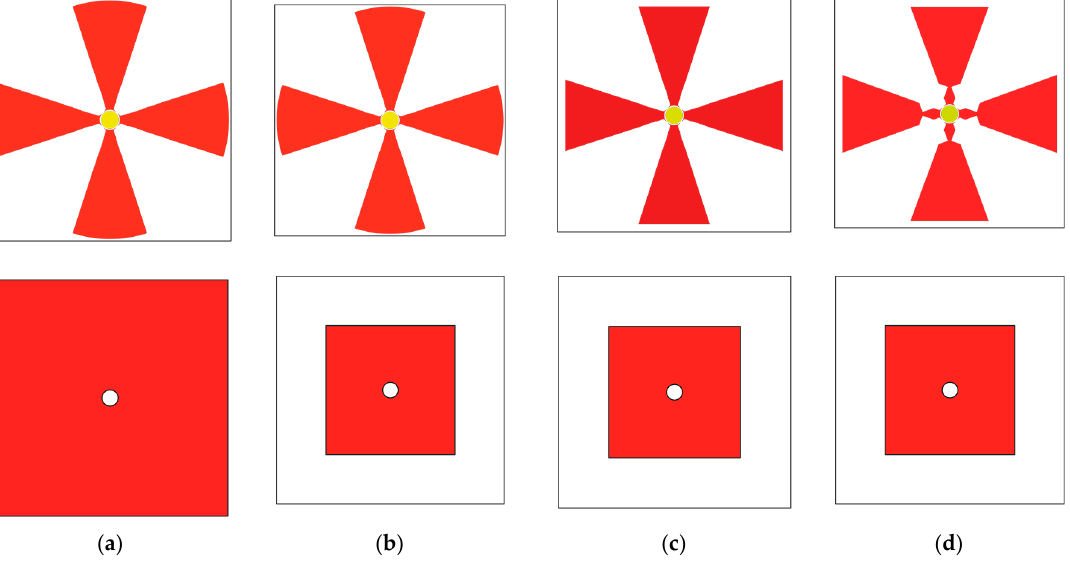
Figure 3. Design evolution of the proposed antenna: ( a ) initial antenna; ( b ) Improved antenna design 1; ( c ) Improved antenna design 2; ( d ) Final antenna.